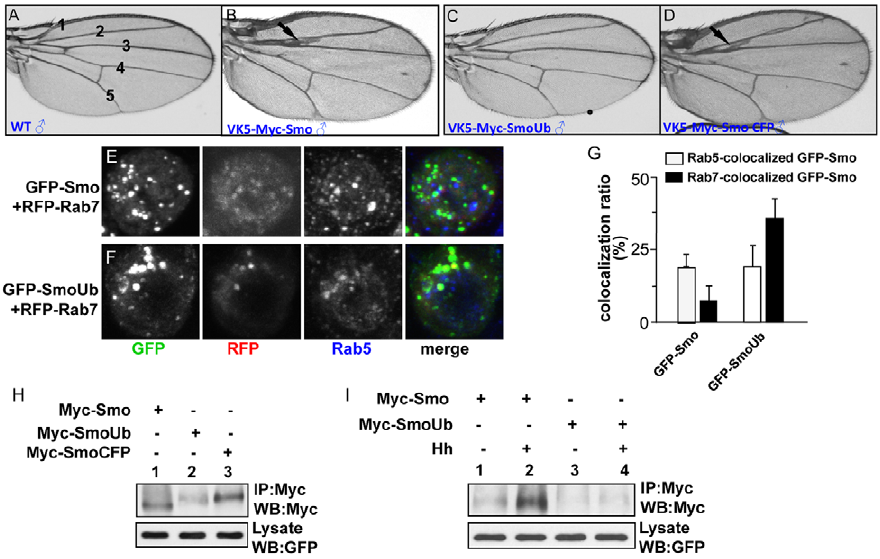
Figure 2. Addition of Ub to the C-terminus of Smo attenuates the signaling activity of Smo. (A) A wild-type adult wing indicates the five interveins. (B–D) Wings expressing Myc-Smo, Myc-SmoUb, or Myc-SmoCFP at the 75B1 attP locus by MS1096 Gal4 to ensure equal expression of each individual constructs. The arrows in (B) and (D) indicate the extra wing structures in the anterior compartment of the wing, which is indicative of anterior ectopic Hh activity that is caused by the expression of wild-type Myc-Smo or Myc-SmoCFP. The wing in (C) shows the wild-type structure, which indicates that the activity of Myc-SmoUb is lower than that of Myc-Smo or Myc-SmoCFP. (E–F) S2 cells were transfected with RFP-Rab7 and GFP-Smo or GFP-SmoUb followed by immunostaining with Rab5 antibody to label the early endosomes. Late endosomes are labeled by RFP-Rab7. GFP indicates the expression and localization of Smo. The images shown in (E–F) are from intensity projection over the z -axis. (G) The percentage of Smo that co-localized with Rab5 or Rab7 compared to the total amount of Smo (GFP puncta) calculated from (E–F) ( n $ 10). More GFP-SmoUb puncta were localized in Rab7-labeled late endosomes compared to GFP-Smo. (H) S2 cells were transfected with Myc-Smo, Myc-SmoUb, or Myc-SmoCFP. Cell extracts were immunoprecipitated with the anti-Myc antibody and blotted with the anti-Myc antibody to examine the levels of Smo. GFP served as a transfection and loading control. Of note, the stability of Myc-SmoUb is much lower than that of Myc-Smo or Myc-SmoCFP. (I) S2 cells were transfected with Myc-Smo, Myc-SmoUb, or Myc-SmoCFP followed by treatment with or without Hh. Cell extracts were subjected to immunoprecipitation and Western blot with the anti-Myc antibody to detect the levels of Smo. Note that Hh stabilizes Myc-Smo (lane 2, top panel) but not Myc-SmoUb (lane 4, top panel). GFP served as a transfection and loading control.